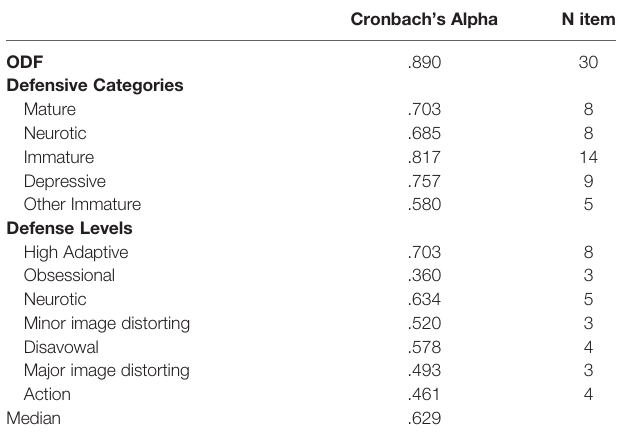
TABLE 2 | Internal consistency and interrater reliability of the 30-item Defense Mechanism Rating Scales Self-Report (DMRS-SR-30).